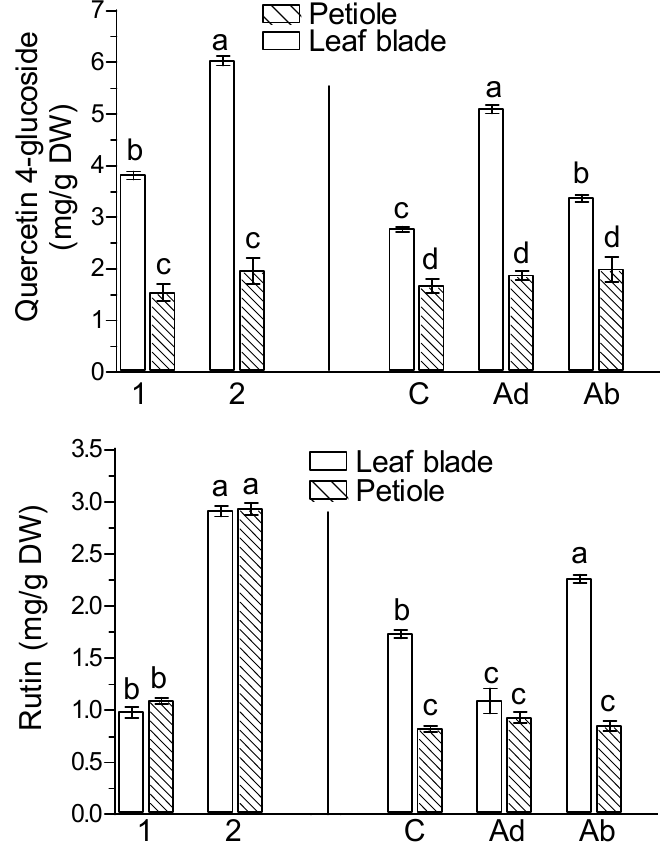
Figure 2. Effect of methyl jasmonate (JA-Me) on the content of flavonols in the leaf blade and petiole of G. biloba . Mean results ± SD followed by the same letter calculated for the natural senescence process and JA-Me treatment separately were not significantly different ( p < 0.05) according to Tukey’s test. Description of samples: 1, initial time (9 September); 2, naturally senesced yellow leaves (20 October); C, control (lanolin); Ad, JA-Me applied to the adaxial side of the leaf blade; Ab, JA-Me applied to the abaxial side of the leaf blade. C, Ad, and Ab samples were collected for analysis on 30 September.